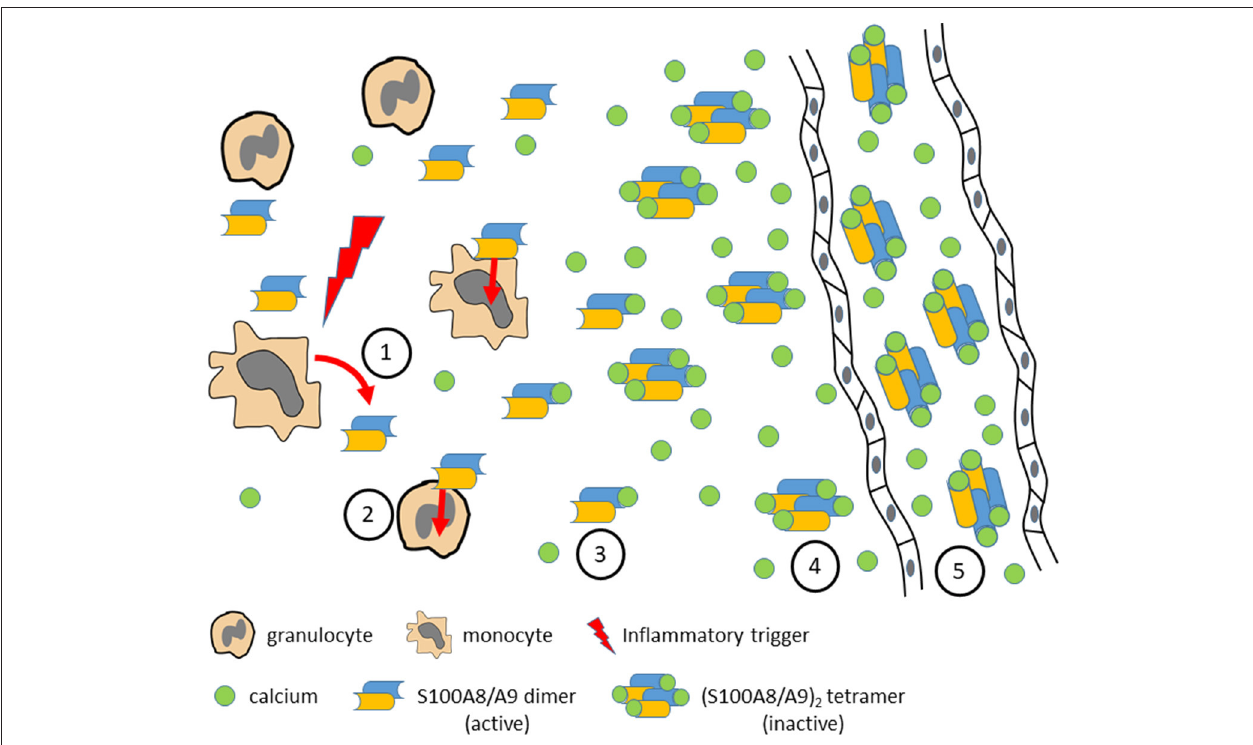
FIGURE 2 | Various inflammatory triggers lead to local release of S100A8/S100A9 dimers by activated monocytes or granulocytes (1). S100A8/S100A9 may bind to TLR4 on different target cells and amplify and perpetuate the inflammatory response (2). With increasing calcium concentrations toward systemic circulation S100A8/S100A9 dimers bind calcium ions (3) and form (S100A8/S100A9) 2 tetramers (4) which show no inflammatory activity any more due to the fact that the TLR4 binding site is hidden in the tetramer interface. In systemic circulation high calcium concentrations prevent systemic inflammatory side effects by stabilization of inactive (S100A8/S100A9) 2 tetramers (5) which, however, are useful biomarkers for monitoring local disease